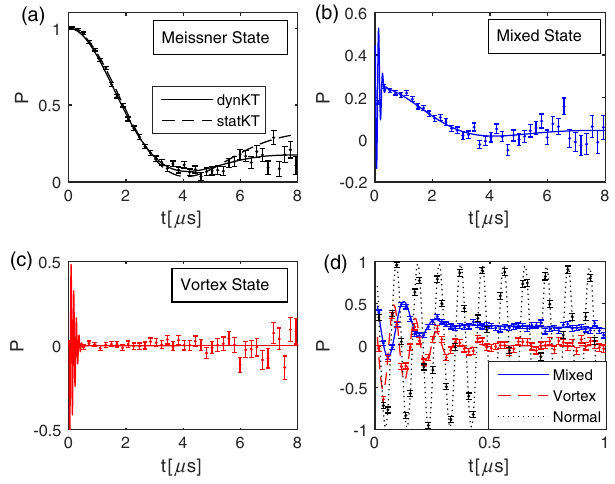
FIG. 4. Polarization function in different states. (a) In the Meissner state the depolarization is caused by randomly orien- tated nuclear dipole fields resulting in the characteristic dynamic Kubo-Toyabe polarization function. For comparison a fit to the static Kubo-Toyabe polarization function is plotted as well. This fit does not give a good representation for longer times. (b) In the mixed state, which is defined by coexisting macroscopic areas in the Meissner and vortex state, the Kubo-Toyabe polarization function is combined with a fast decaying oscillating function. (c) In the vortex state all muons sense the external field and there is no signature of the Kubo-Toyabe polarization function left. Here the strong damping is caused by the non uniformity of the vortex field structure. (d) In the normal state all muons probe the same field yielding weaker damping. Note the different time scale in this